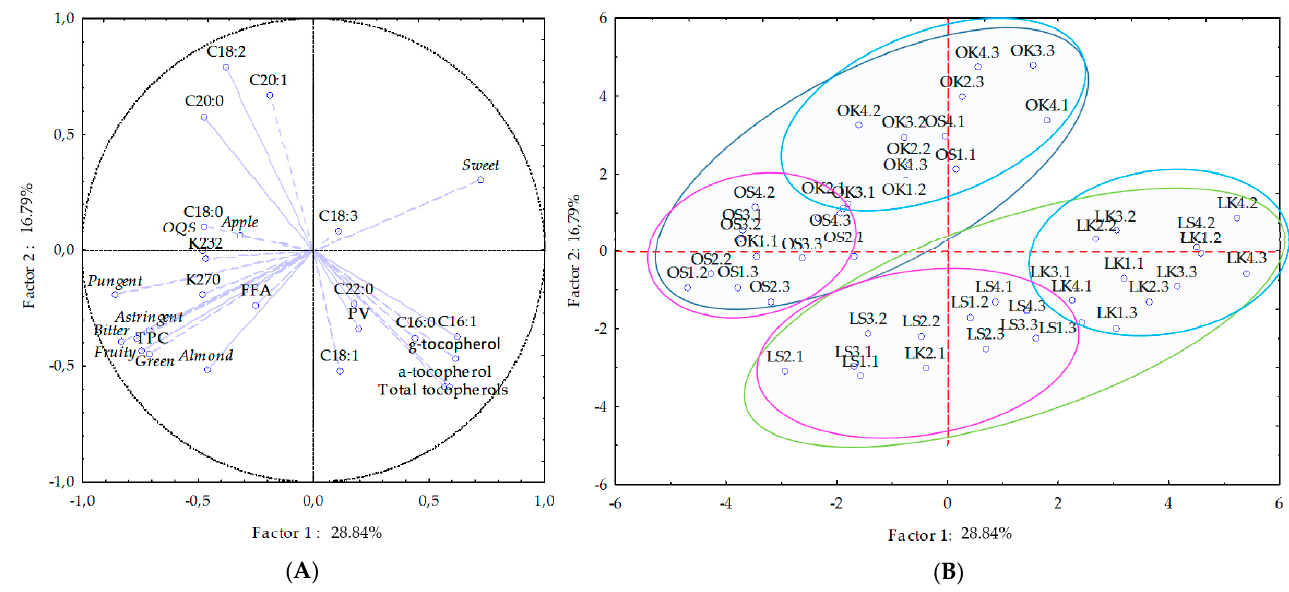
Figure 5. ( A ) Projection of the variables (basic quality parameters (FFA, PV, K numbers), fatty acid composition, tocopherol composition, total phenols (TPC) and sensory properties) of the first two factors, obtained by principal component analyses; and ( B ) projection of the virgin olive oil samples of Oblica (O) and Leccino (L) grown in Kaštela (K) and Šestanovac (S) during ripening (1–4, harvest period, also see Table 1) in 3 successive crop years (1–3, number after the point) in the two-dimensional space of first 2